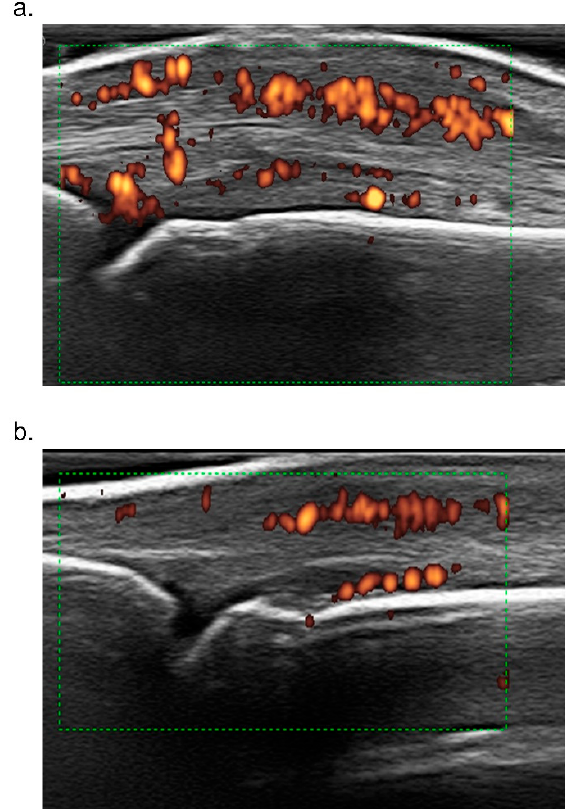
Figure 3. Ultrasound dorsal scan of the third metacarpophalangeal joint of the right hand of our patient. Swelling of the periarticular tissues, power doppler signal (red dots) of the joint and in the peritendon of the extensor of the finger were more evident at baseline ( a ). After 6 months, the power doppler signal and the periarticular swelling were considerably reduced ( b ).